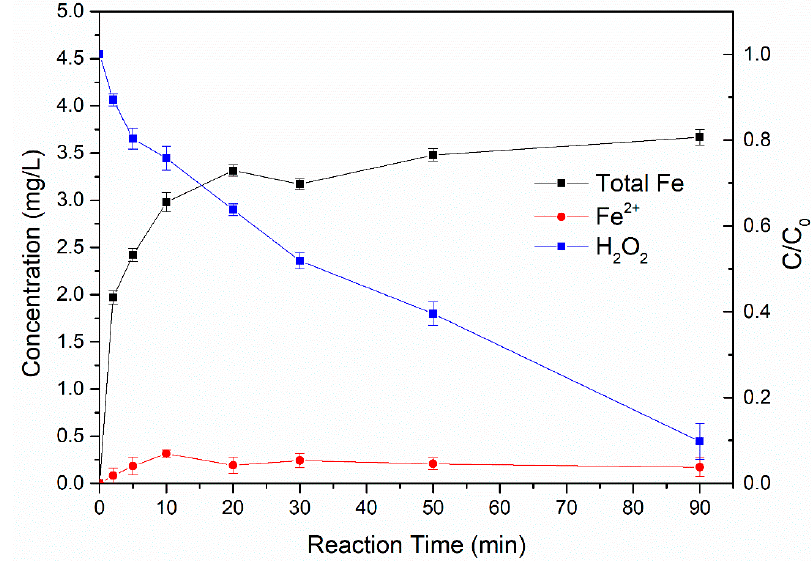
Figure 8. Changes of Fe 2+ and Fe 3+ concentrations in the Fe 0 @Fe 3 O 4 /H 2 O 2 system ([2,4-D] 0 = 5.0 mg/L, [Fe 0 @Fe 3 O 4 ] 0 = 0.5 g/L, H 2 O 2 = 1 mM, pH = 5.0 ± 0.2, T = 30 °C).